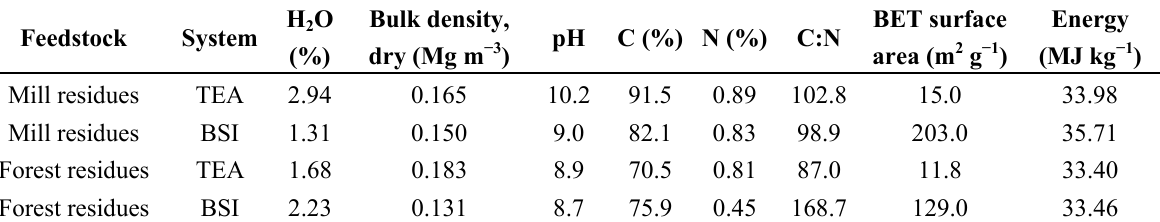
Table 3. Biochar